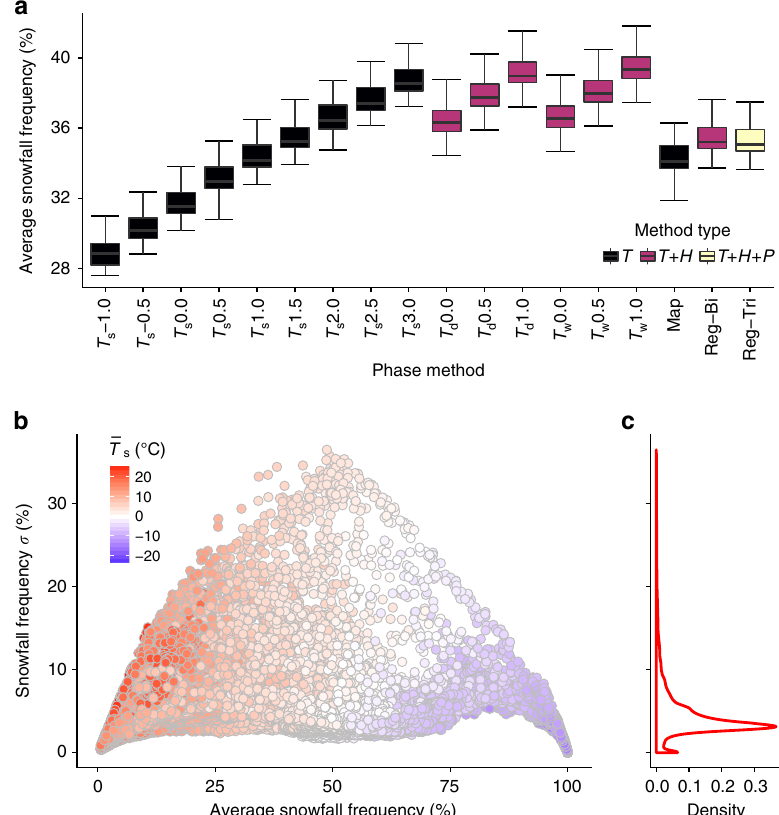
Fig. 6 Average Northern Hemisphere snowfall frequency and standard deviation. a Average Northern Hemisphere snowfall frequency as computed by the 18 different methods applied to 27 years of MERRA-2 reanalysis data. Shading represents the data included in each method ( T — air temperature; H — humidity via RH, T w , or T d ; and P — pressure). b The standard deviation of snowfall frequency plotted against average snowfall frequency for each MERRA-2 grid cell for the 18 precipitation phase methods. Shading represents the average T s for that grid cell during precipitation events. c Density plot showing the distribution of snowfall frequency standard